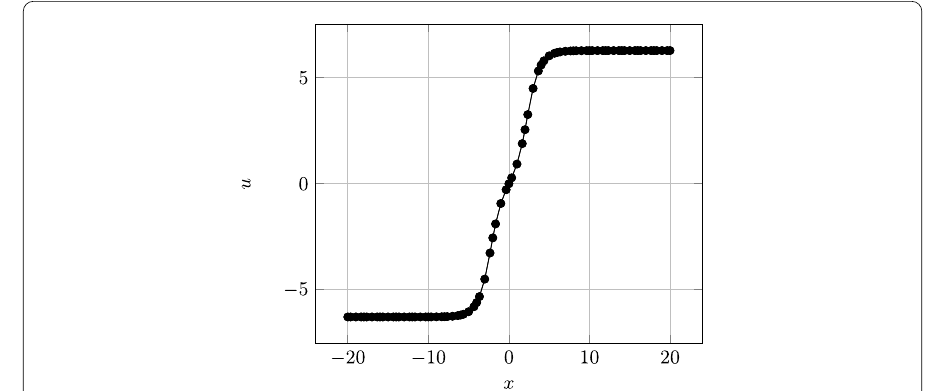
Figure 3 Comparison between the LSEM and exact solutions for Example 5.1 at T = 1 with N = 4, N e = 20 and k = 0.1